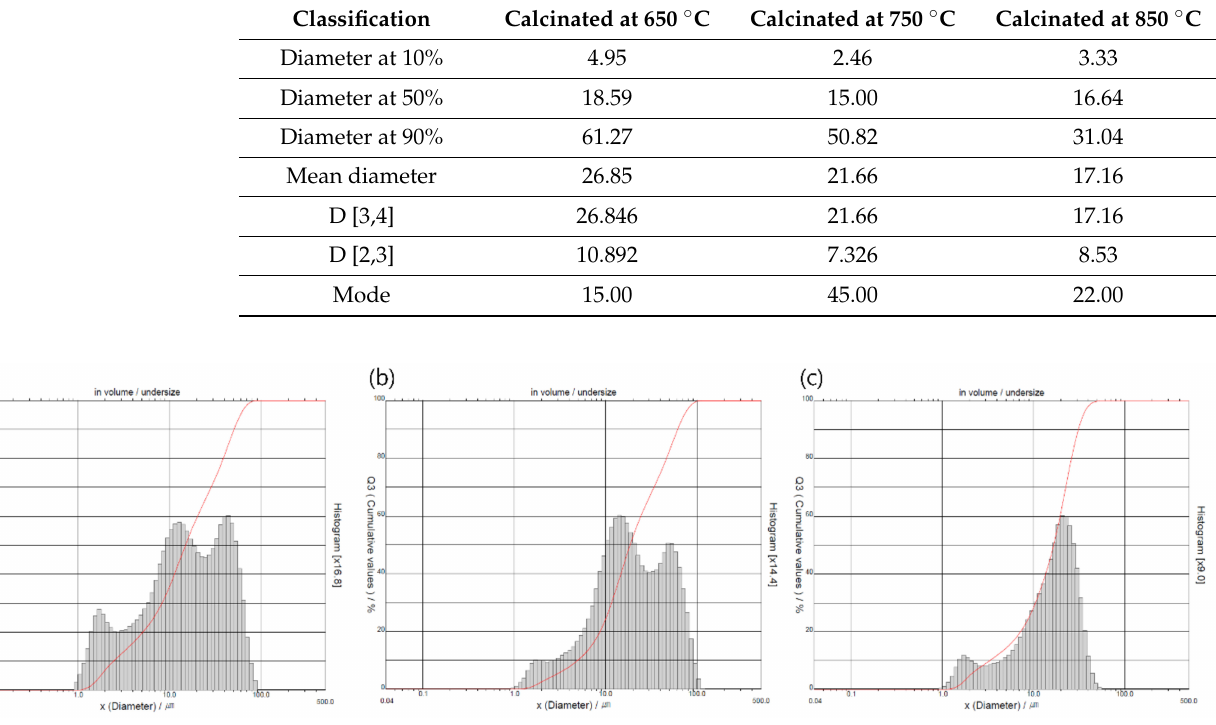
Figure 14. Particle size distribution graphs: ( a ) CC6. ( b ) CC7. ( c )